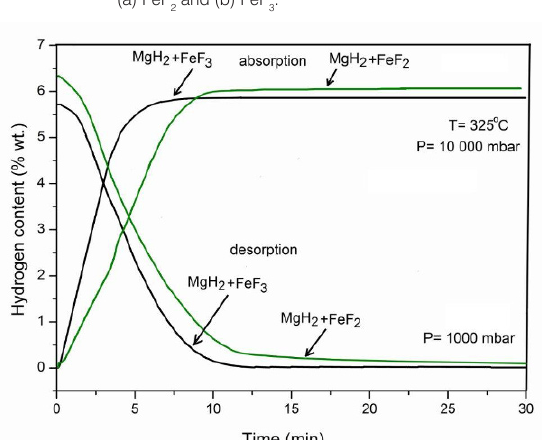
Figure 3. The kinetic curves of hydrogen absorption and desorption